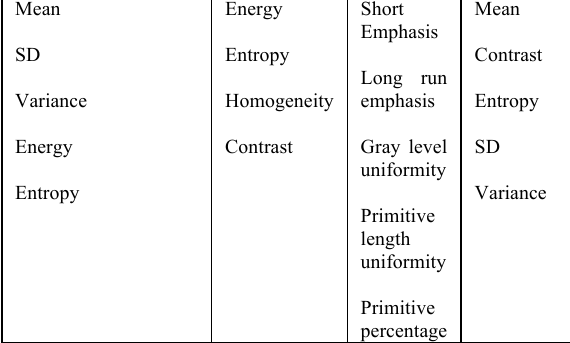
Table 1: Textural Features